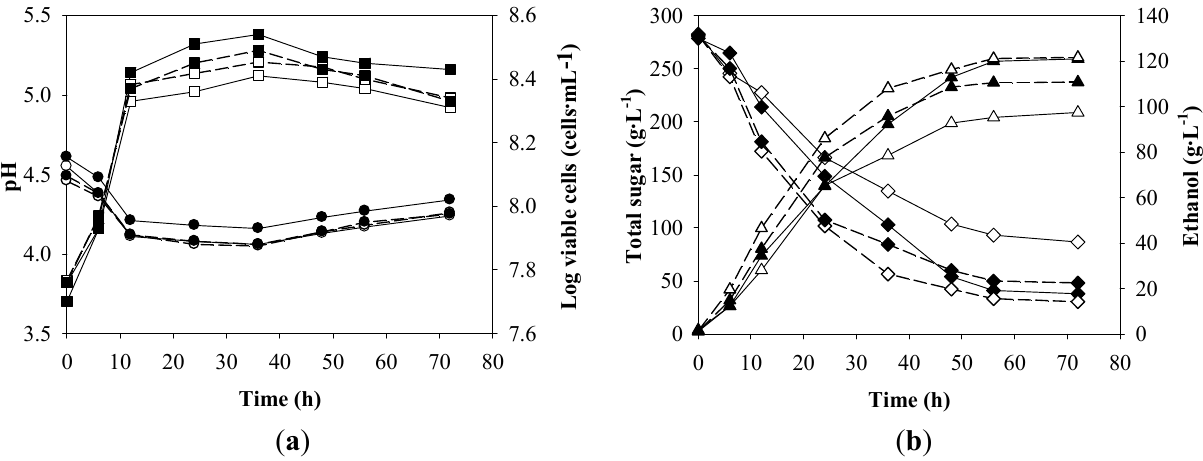
Figure 3. Batch ethanol fermentation in the 2-L fermenter from the synthetic medium containing 280 g·L − 1 of total sugar and nutrient supplements at the optimum nutrient concentrations (yeast extract, 3; DSY, 4 and glycine, 5 g·L − 1 ) (closed symbols, solid lines), without nutrients supplement (open symbols, solid lines), with 9 g·L − 1 of yeast extract (open symbols, dashed lines) and with 13.4 g·L − 1 of DSY (closed symbols, dashed lines). ( a ) pH ( ●○ ) and log viable cells ( ■□ ) and ( b ) total sugar ( ♦ ◊ ) and ethanol ( ▲ (cid:4574)